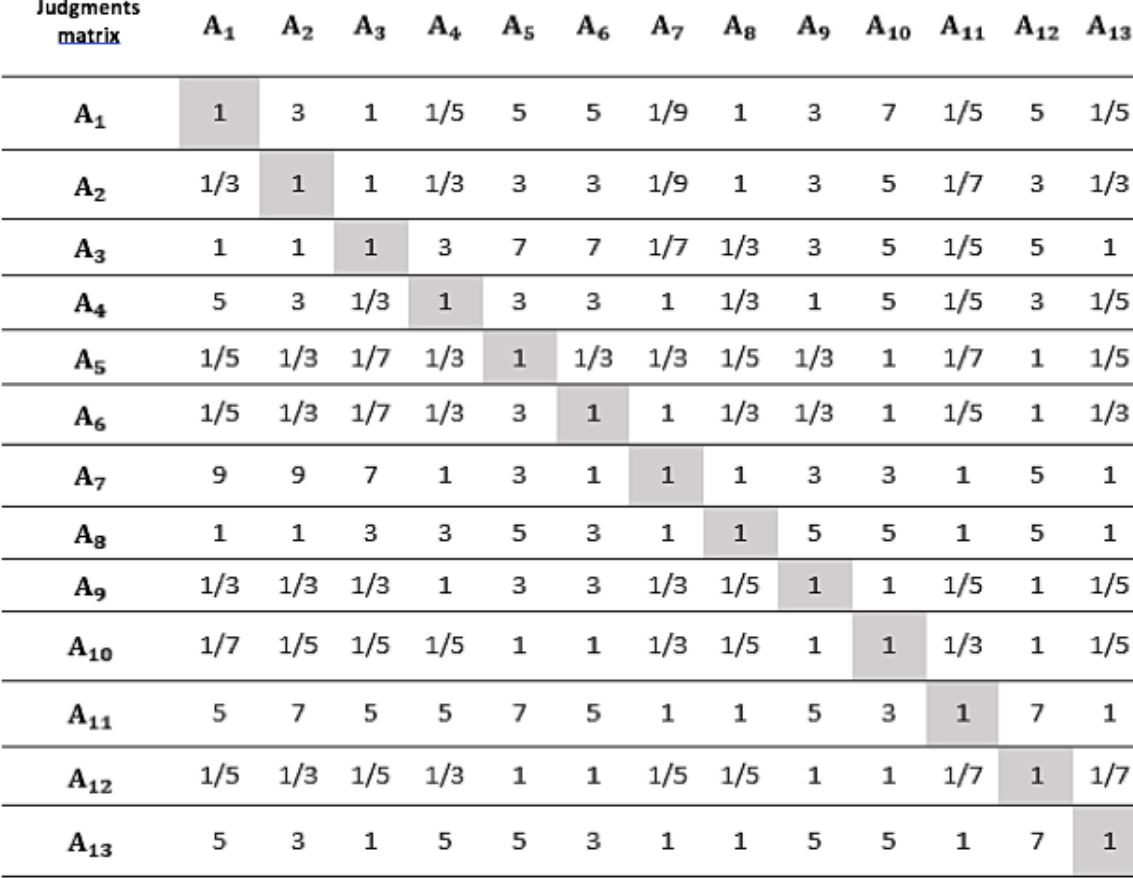
Figure 3 - Judgments matrix among alternatives with respect to an